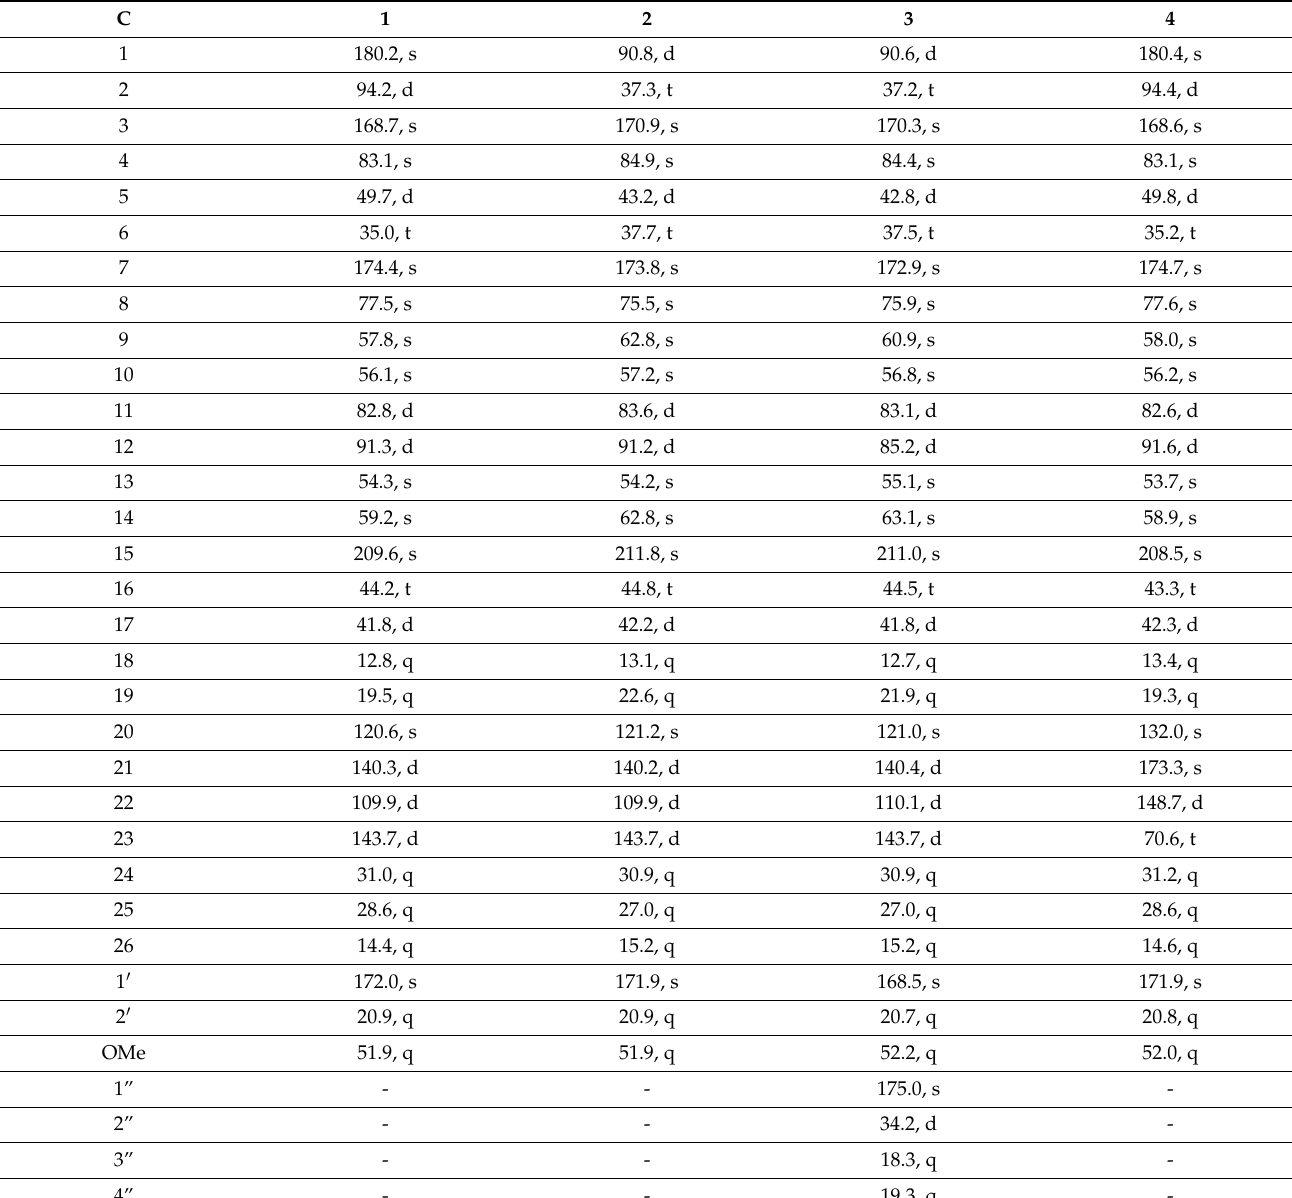
Table 2. 13 C NMR spectroscopic data for 1 – 4 recorded in CDCl 3 . The chemical shifts are in ppm, the multiplicities were determined by DEPT and HMQC experiments. The solvent signal at 77.0 ppm was used as a